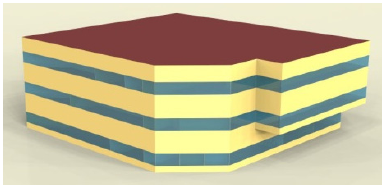
Figure 2. Case study energy model.